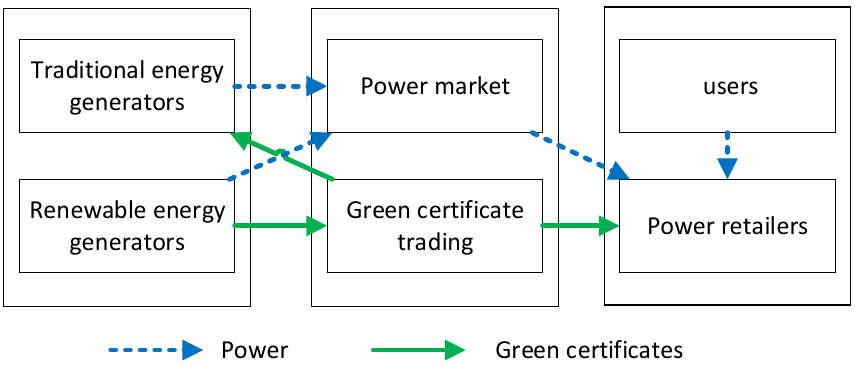
Figure 3. Power market and green certificate trading.